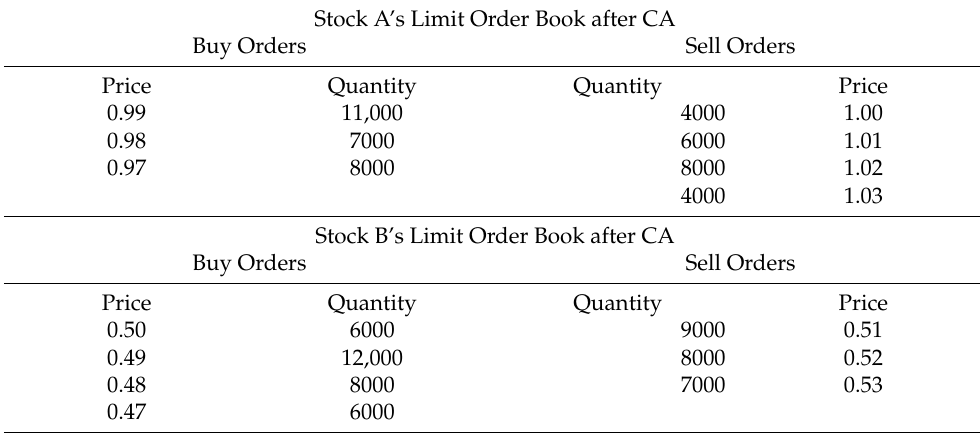
Table 2. Order Books at the Completion of